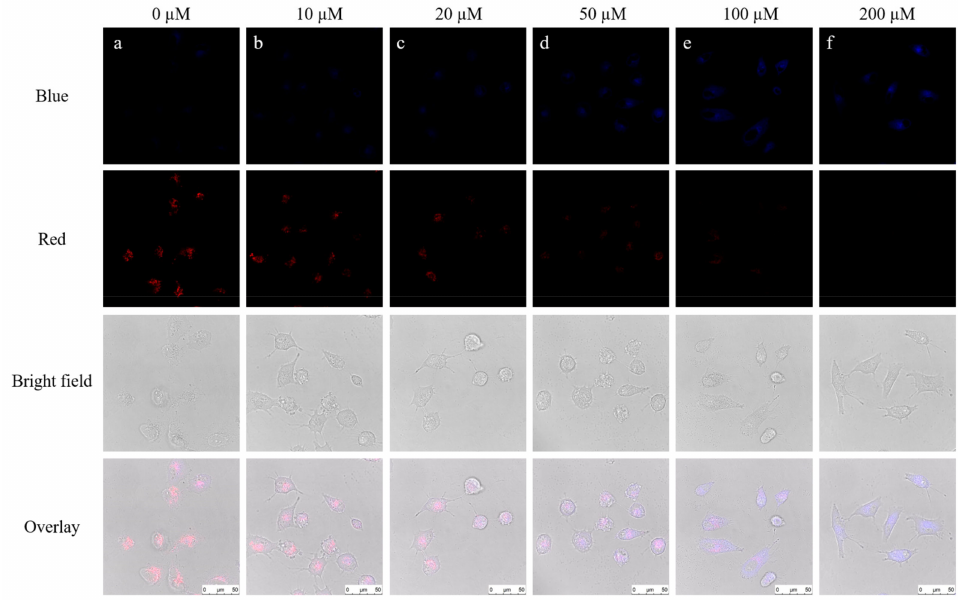
Figure 6. Imaging of SO 32 − in HepG2 cells by the probe. The cells were stained with ( a ) 10 µ M probe EB for 2 h; ( b ) 10 µ M SO 32 − for 2 h, 10 µ M probe EB for 2 h; ( c ) 20 µ M SO 32 − for 2 h, 10 µ M probe EB for 2 h; ( d ) 50 µ M SO 32 − for 2 h, 10 µ M probe EB for 2 h; ( e ) 100 µ M SO 32 − for 2 h, 10 µ M probe EB for 2 h; ( f ) 200 µ M SO 32 − for 2 h, 10 µ M probe EB for 2 h; Blue channel: λ ex = 405 nm; λ em = 450–490 nm; Red channel: λ ex = 488 nm; λ em = 550–590